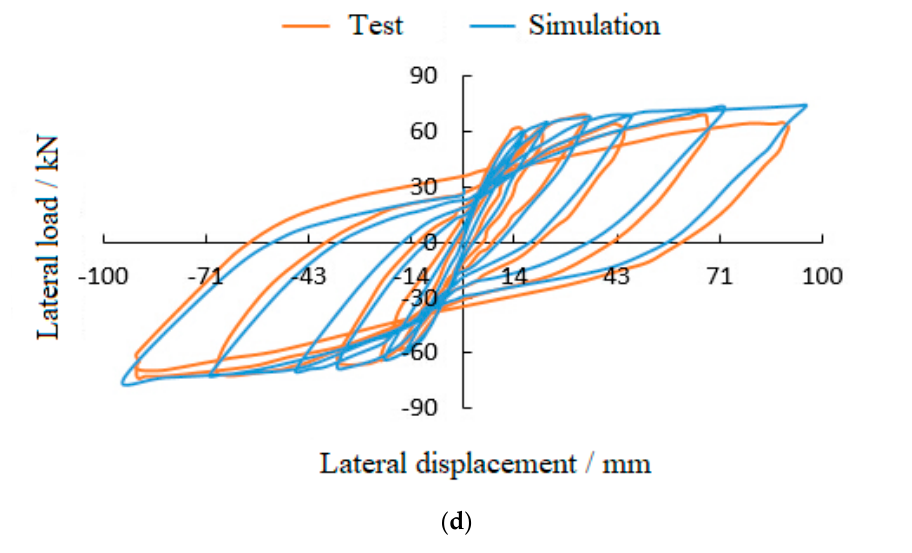
Figure 4. The results of test in literatures [18] and [40] versus numerical results for hysteretic Scheme 1. ( a ) AR-1, ( b ) Scheme 3. ( c ) Specimen BR-1, and ( d ) Tall Circular Column specimen.